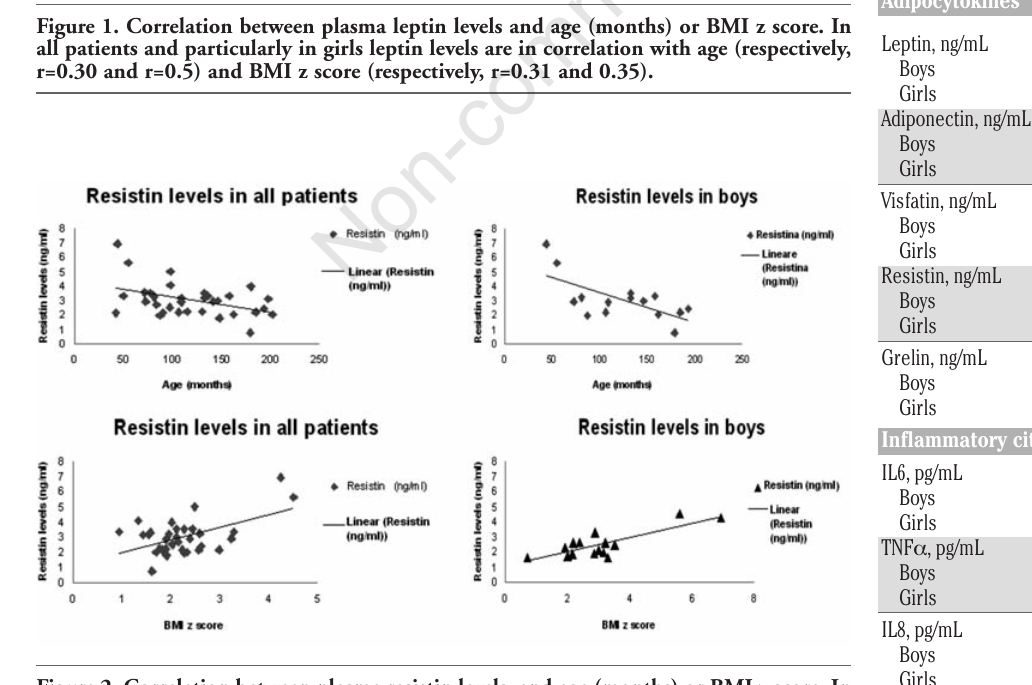
Figure 2. Correlation between plasma resistin levels and age (months) or BMI z score. In all patients plasma resistin levels are in correlation with age (r=0.42) and BMI z score (r=0.52); in boys resistin levels are in stronger correlation with age (r = -0.67) and BMI z score (r=0.8).